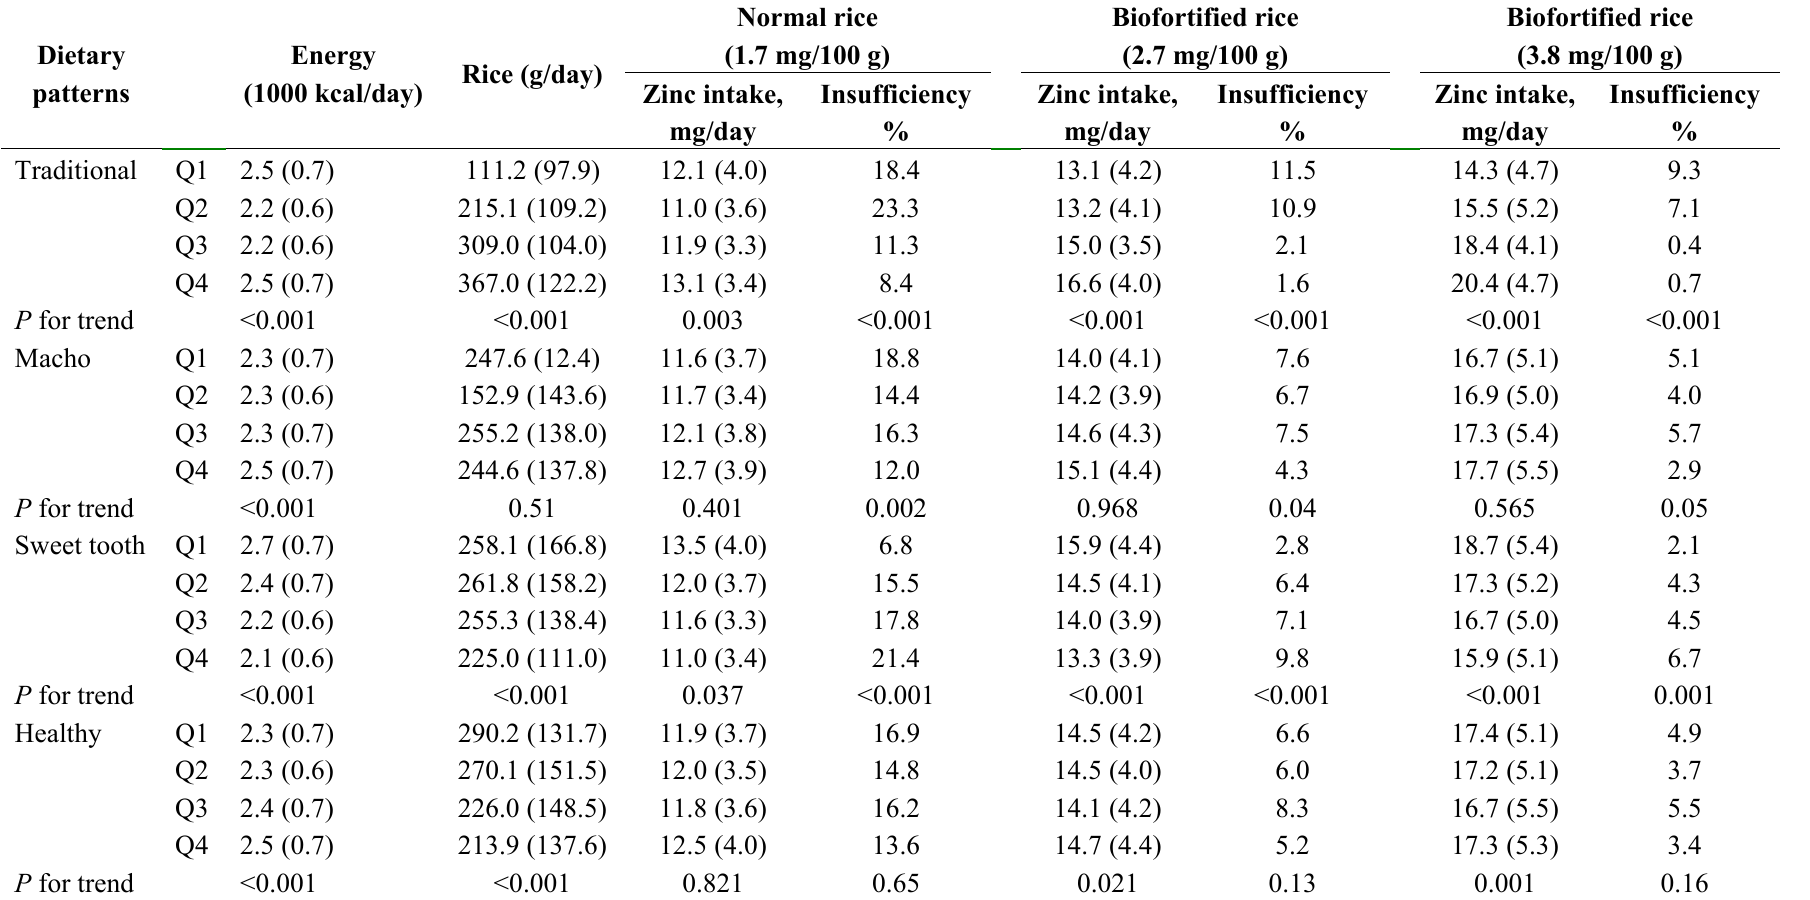
Table 4. Dietary zinc intake (mg/day) and prevalence of insufficiency of dietary zinc intake (%) with normal rice and biofortified rice in each of the dietary